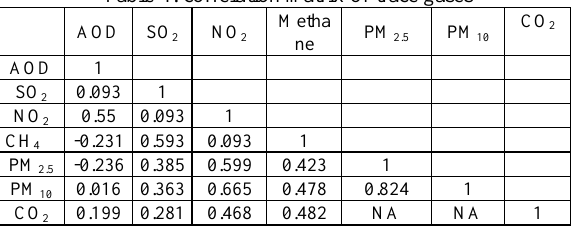
Table 4: correlation matrix of trace gases